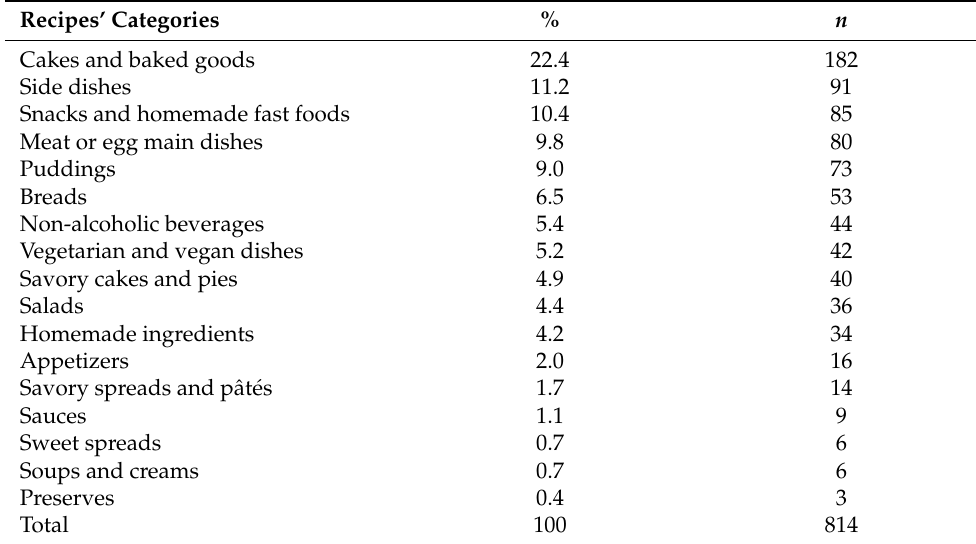
Table 1. Categories of 814 culinary recipes available on the ‘healthy eating’ section of a